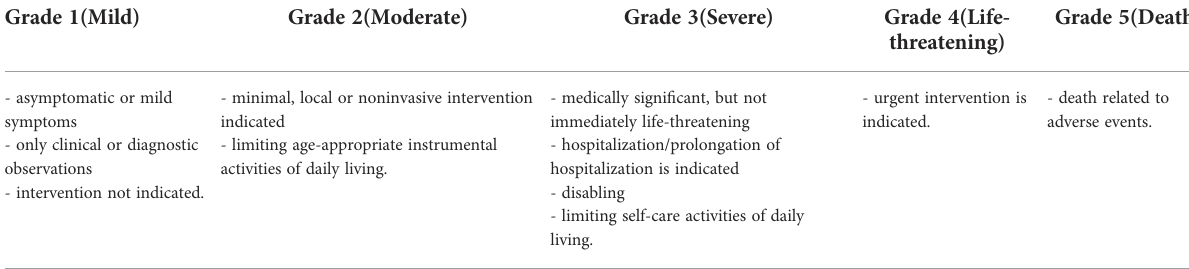
TABLE 2 Grading guidelines proposed by Common Terminology Criteria for Adverse Events (CTCAE) (applicable for immune-related adverse events induced by immune checkpoint inhibitors).